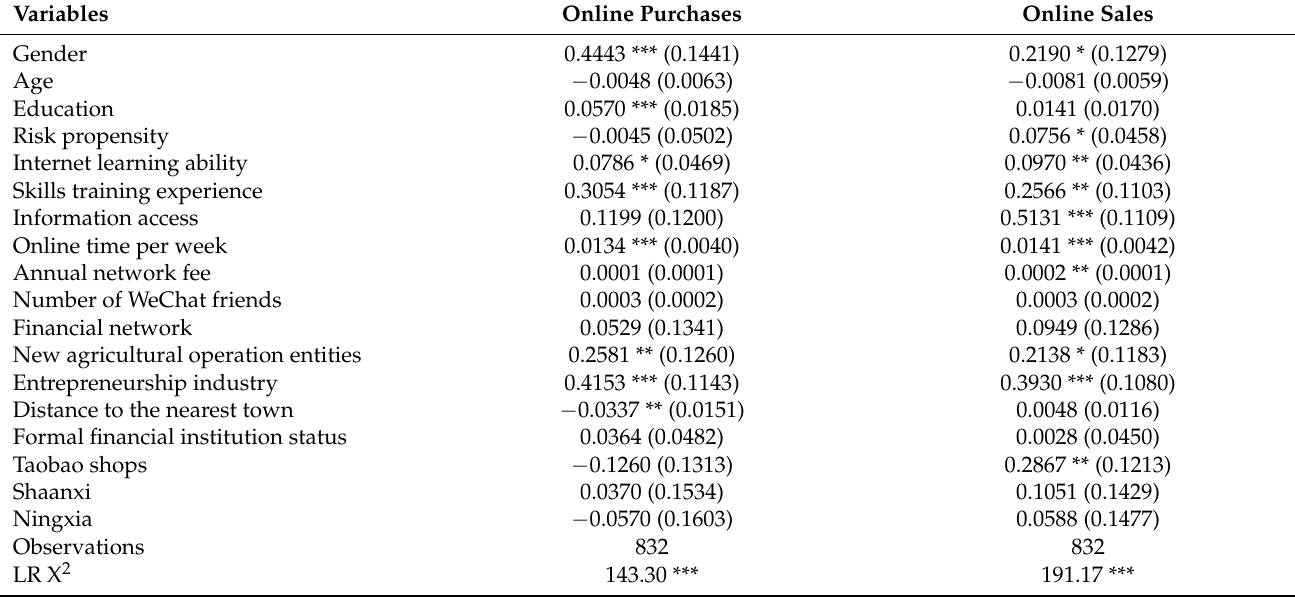
Table A2. Determinants of adoption of online purchases and sales.